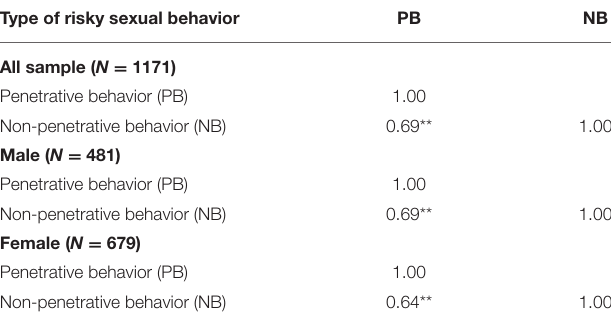
TABLE 3 | Pearson correlations of self-reported risky sexual